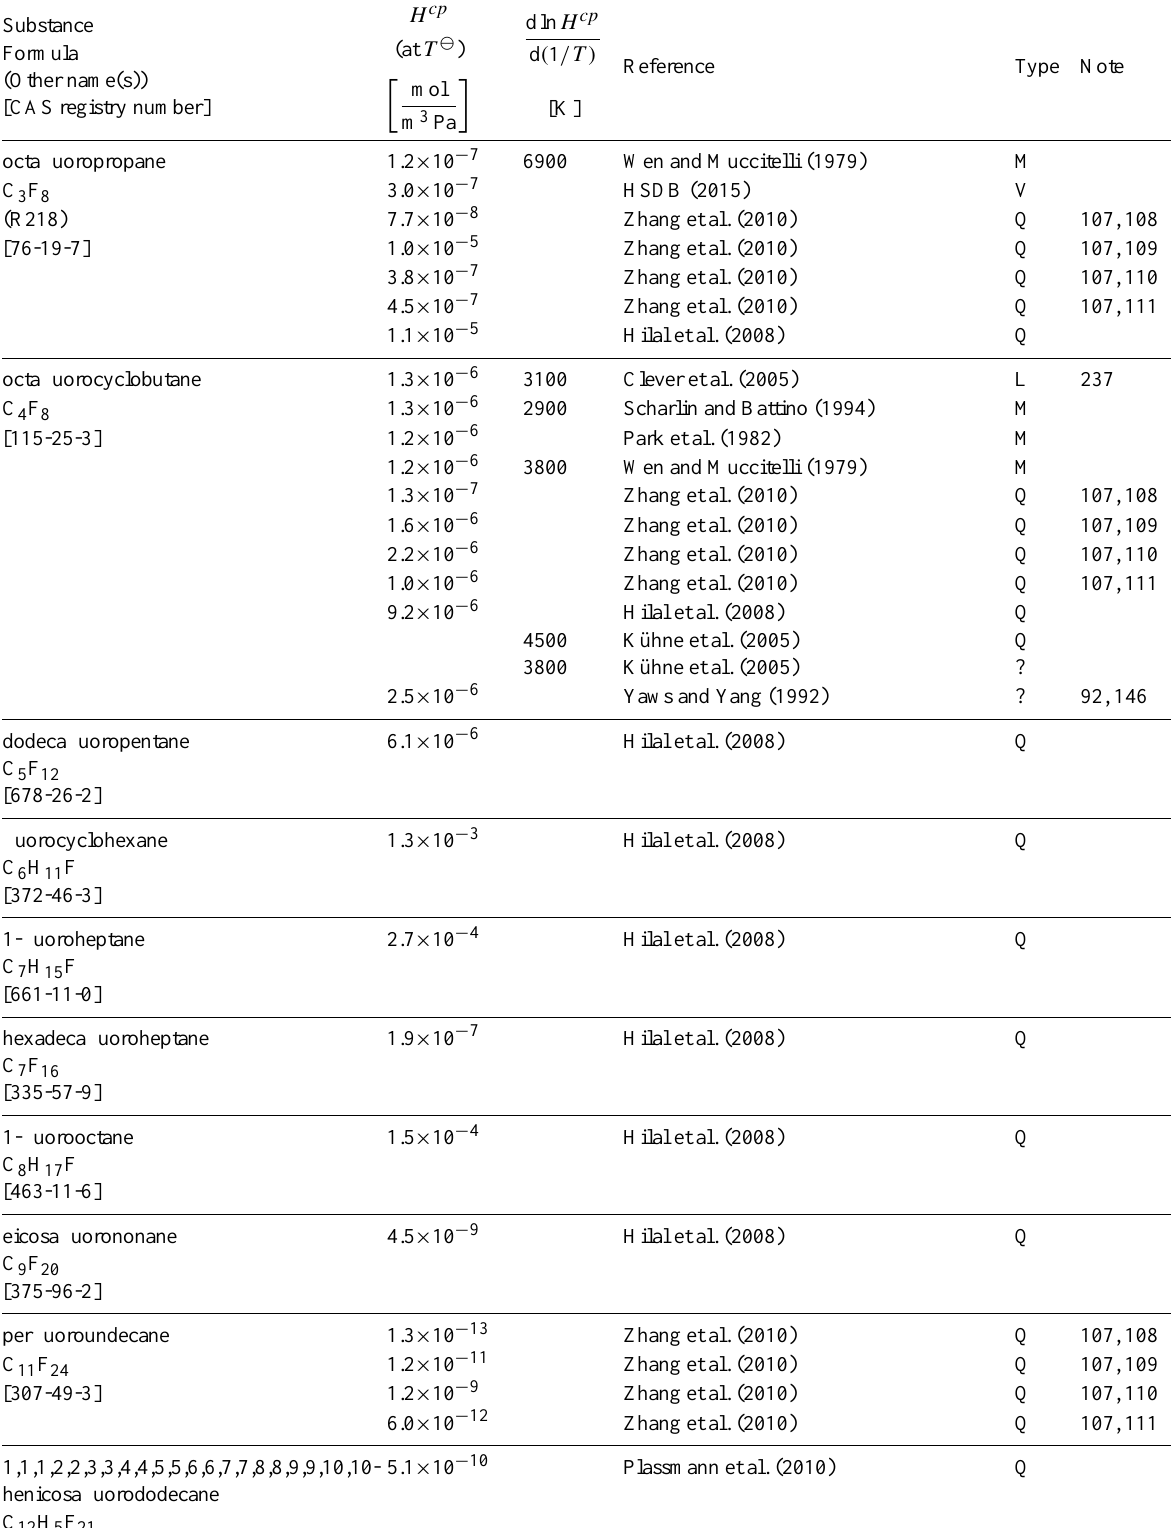
Table 6: Henry’s law constants for water as solvent